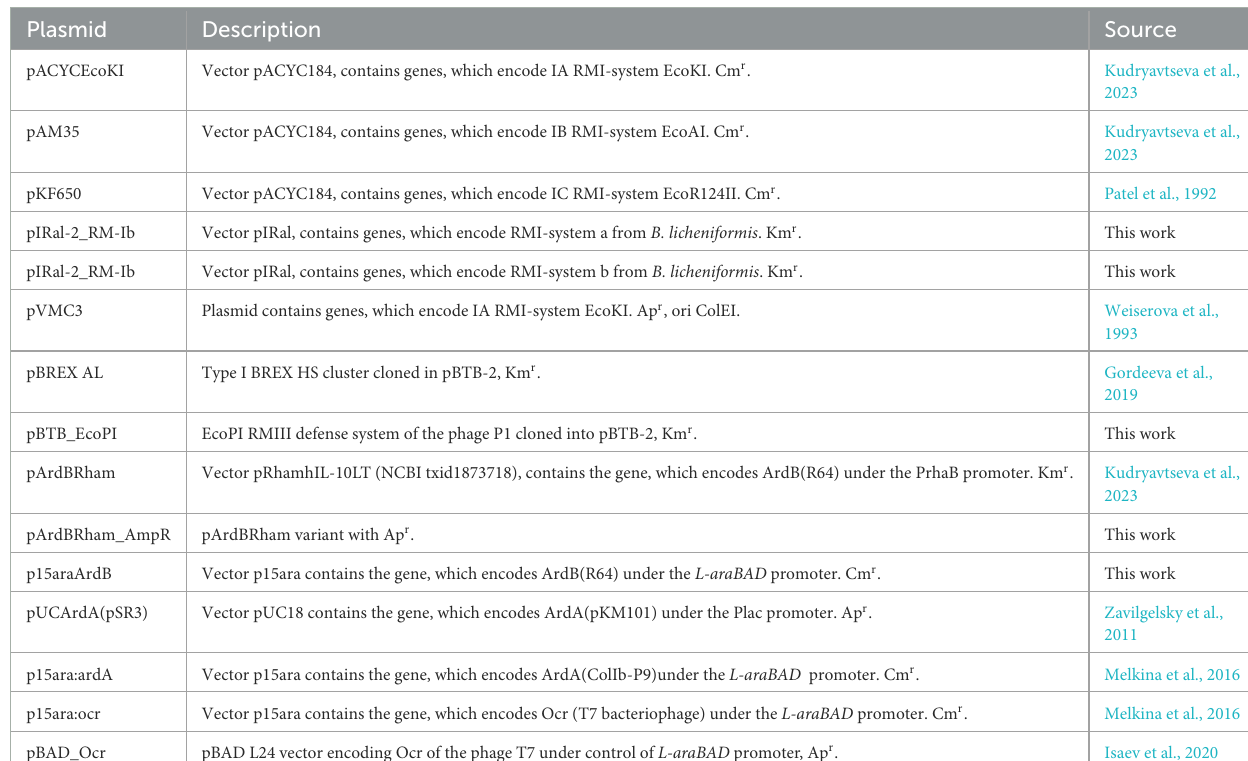
TABLE 1 Plasmids used in the present study. Plasmid